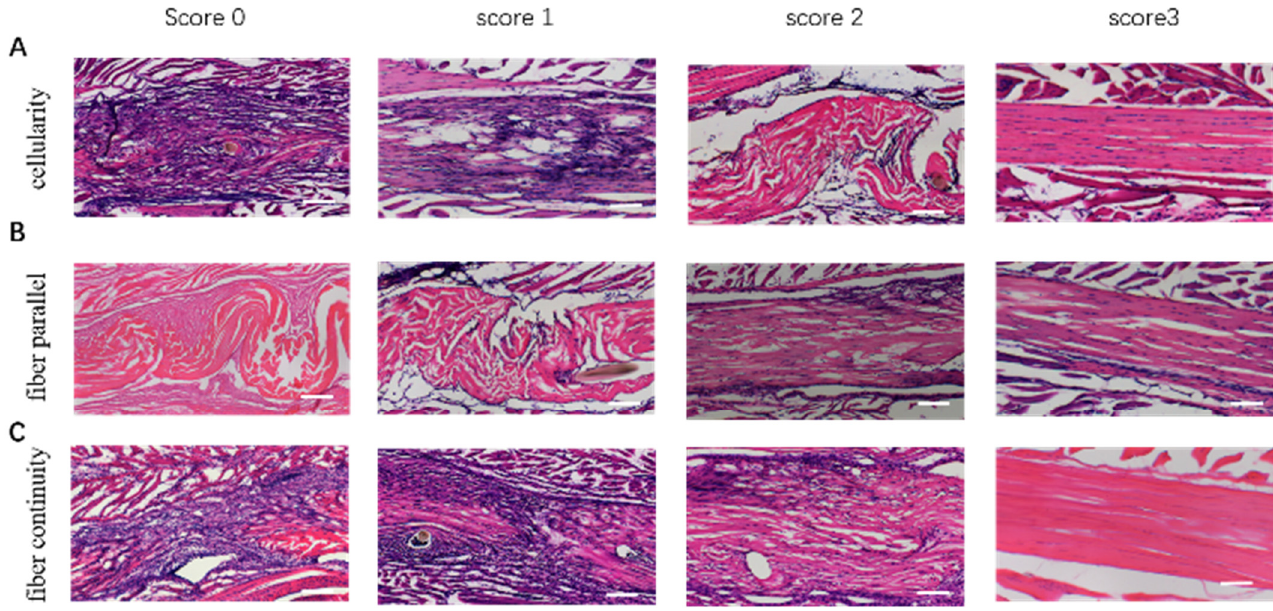
Figure A3. The histological evaluation standards for tendon healing. ( A ) Score of cellularity. Score 0: marked; Score 1: moderated; Score 2: mild; Score 3: minimal. ( B ) Score of parallel fibers. Score 0: less than 25% of fibers oriented parallel to the longitudinal axis; Score 1: 25–50% of fibers oriented parallel to the longitudinal axis; Score 2: 50–75% of fibers oriented parallel to the longitudinal axis; Score 3: more than 75% of fibers oriented parallel to the longitudinal axis. ( C ) Score of fiber continuity. Score 0: less than 25% of fibers showing continuity; Score 1: 25–50% of fibers showing continuity; Score 2: 50–75% of fibers showing continuity; Score 3: more than 75% of fibers showing continuity. Scale bars, 200 µ m.